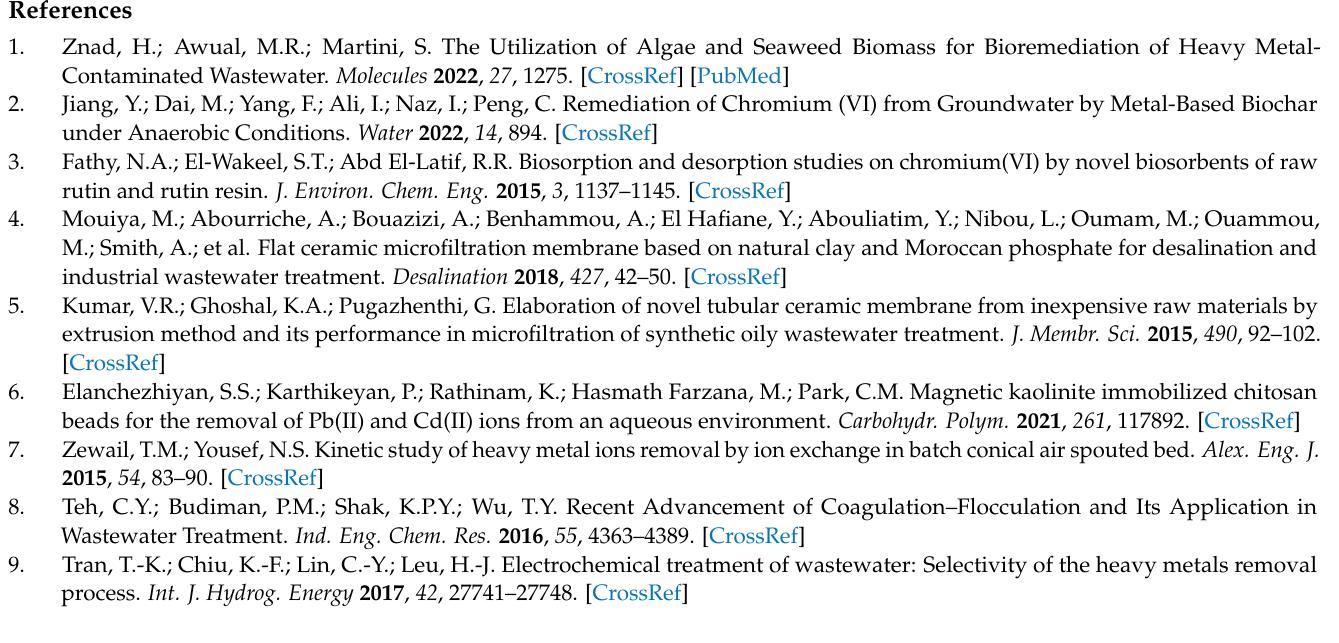
Figure S2: SEM images and mapping images of CMs before coating and after coating with crosslinked chitosan; Figure S3: SEM images of CM surface after sintering at 950 ◦ C (a), 1000 ◦ C (b), 1050 ◦ C (c), 1100 ◦ C (d), and 1150 ◦ C (e) for 3